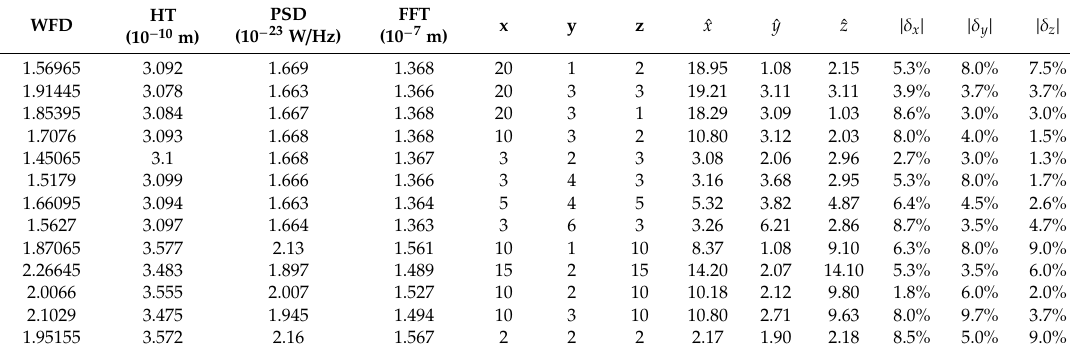
Table 3. Evaluation results of damage size prediction values for 13 testing samples.